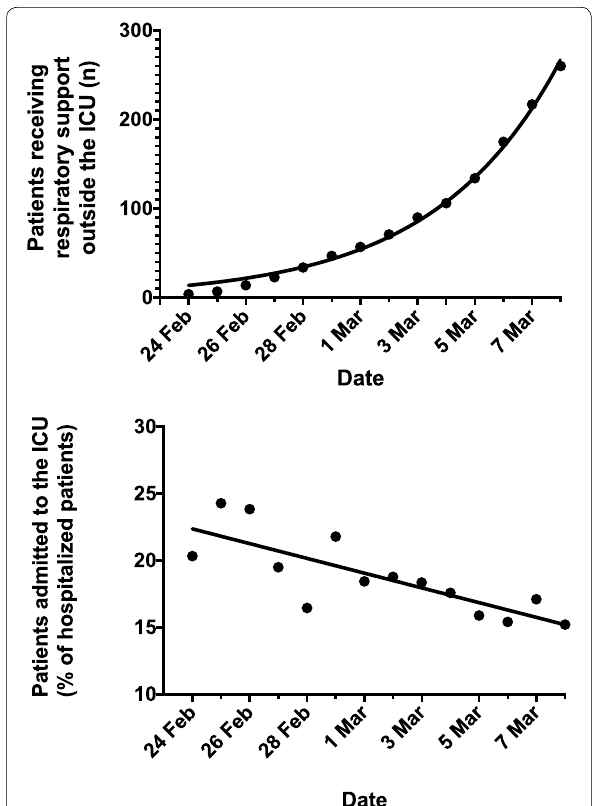
Fig. 1 Number of patients assessed by the intensivist and treated outside the intensive care unit; fitted curve is exponential (top); proportions of patients admitted in the intensive care expressed as percentage of total hospitalized patients; linear fitting